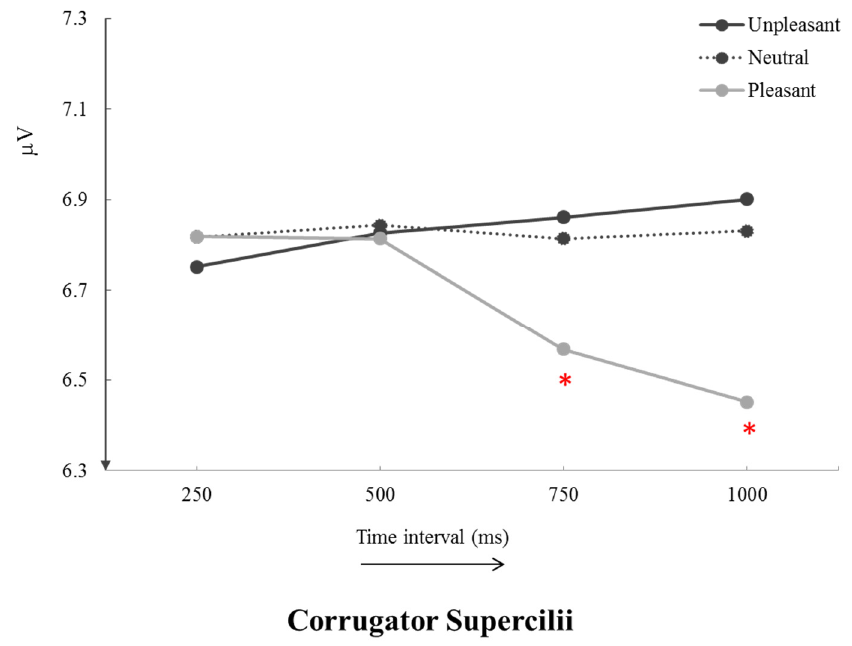
Figure 3. Mean corrugator activity at four time intervals within the first second of picture viewing. The mean for each time interval represents the average of all data points within the 250 ms interval. Means were collapsed over referential conditions to show the cumulative effect of each emotional picture category. Asterisks mark variables with significant results.